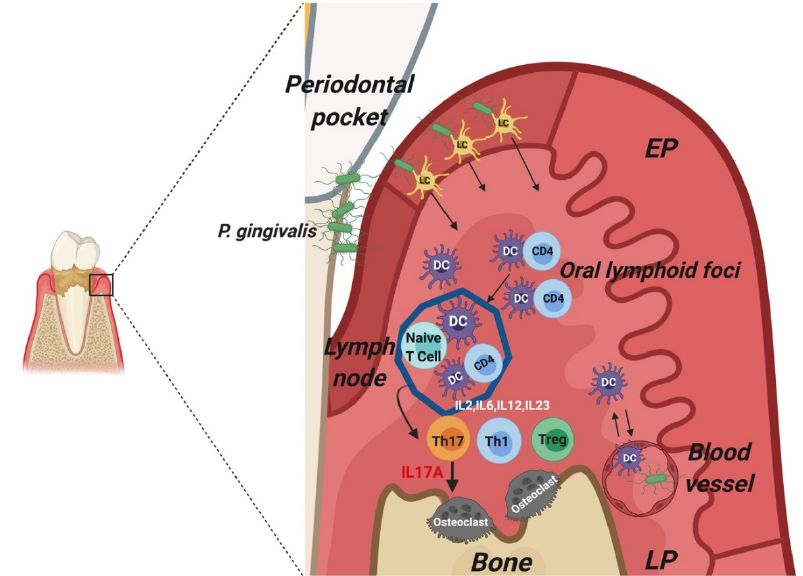
Figure 3. Role of mature DC-CD4 + T cells clusters in osteoclastogenic response. Mature CD83 + MHCII + DCs in lamina propria (LP) engage with CD4 + T cells and elicit destructive recall